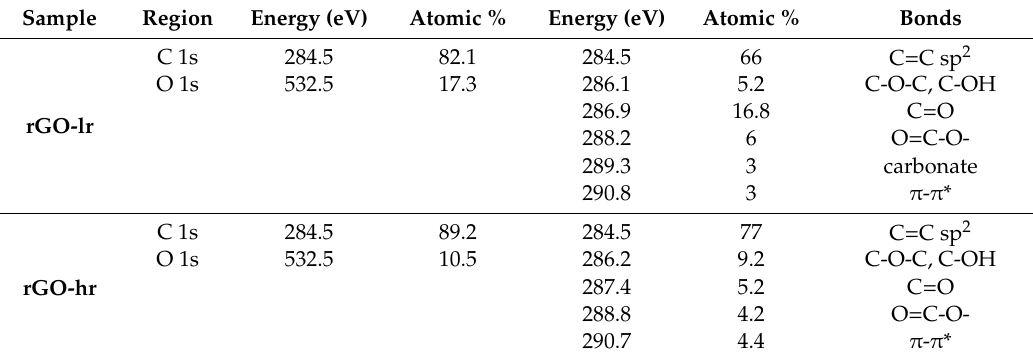
Figure 4. Morphology of the human Wharton’s jelly umbilical cord-derived mesenchymal stem/stromal cells (hUC-MSCs) cultured on the GO and rGO surfaces after 24, 48, and 72 h of culture. Representative images are presented; magnification: 100×. The arrows indicate morphological changes of the hUC-MSCs. Legend: GO-sf-1: small flakes/thick layer; GO-sf-2: small flakes/thin layer; GO-lf-1: large flakes/thick layer; GO-lf-2: large flakes/thin layer; rGO-hr-1: high reduction level/thin layer; rGO-hr-2: high reduction level/thick layer; rGO-lr-1: low reduction level/thin layer; rGO-lr-2: low reduction level/thick layer; Control: tissue culture plastic surface (TCPS). 2.3. The Influence of the GO and rGO Samples on hUC-MSC Proliferation Proliferative responses represent a prognostic value of the reaction of cells to a culture condition. Our results evidenced the impact of the GO and rGO samples on the proliferative activity of hUC- MSCs. The results indicated that a thick layer of GO was less favorable for hUC-MSC growth, while the size of the GO flakes did not significantly impact their proliferation (Figure 5A). On the other hand, the number of hUC-MSCs cultured on the slightly reduced rGO surfaces (rGO-lr-1 and rGO- lr-2 samples) was similar to that in case of the control conditions. Interestingly, we observed a significant decrease in the proliferation activity when the cells were cultured on highly reduced rGO scaffolds (Figure 5B). In particular, we observed a decrease in the proliferation rate of hUC-MSCs cultured on: i) a thin layer (rGO-hr-1) and ii) a thick layer (rGO-hr-2) of highly reduced GO by 50% and 60%, respectively.